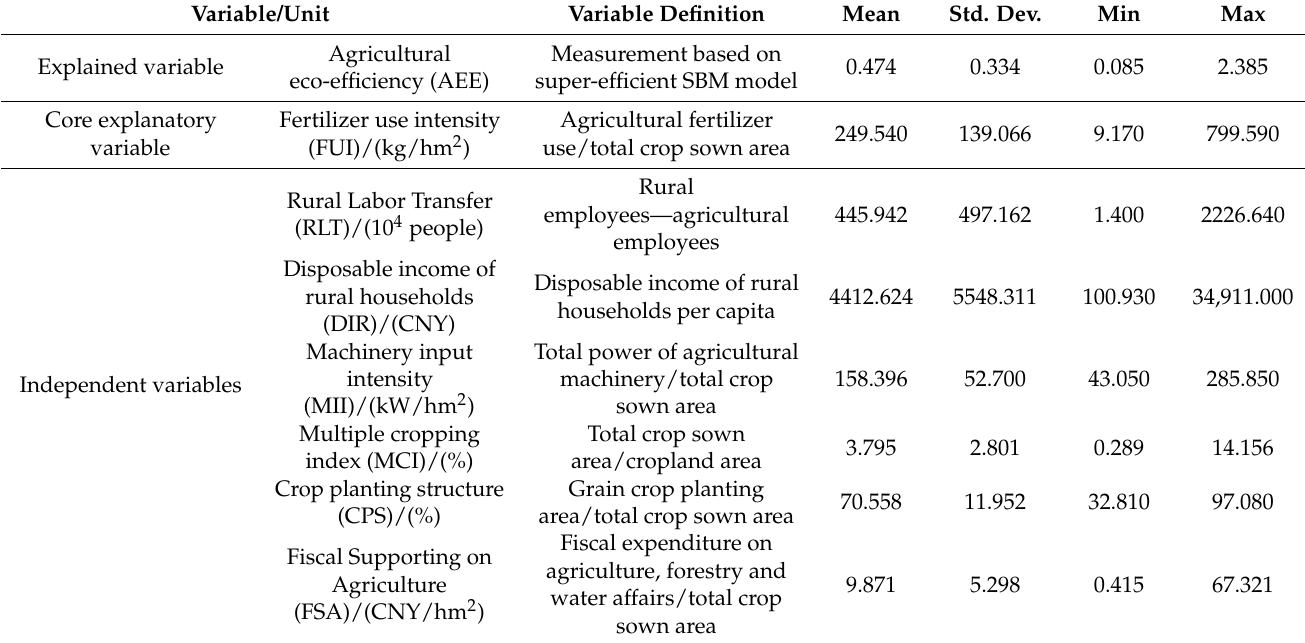
Table 2. Variables definition and descriptive